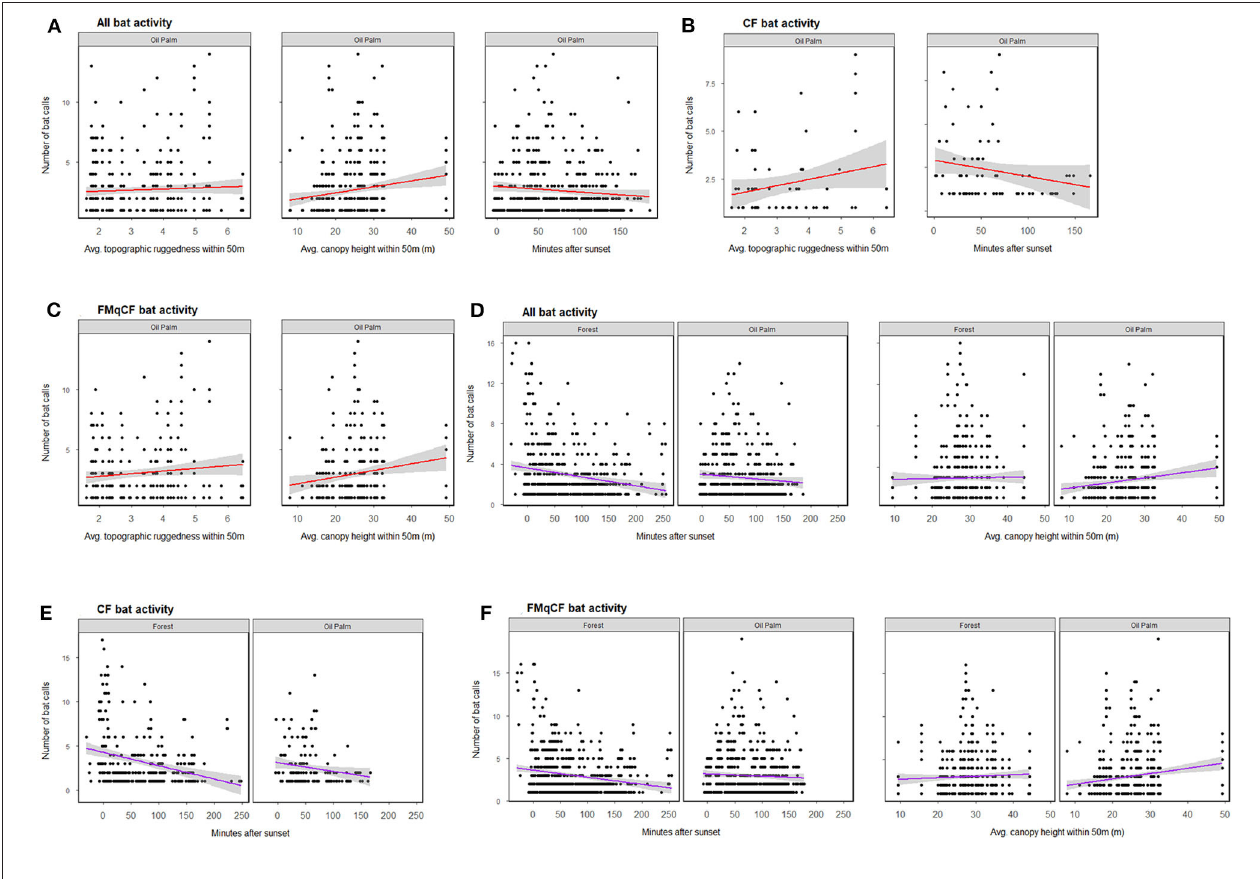
FIGURE 3 | The relationship between bat activity (per sample point) and significant habitat covariates as determined by GLMM analysis for each call group per habitat type. (A–C) Show relationships from GLMMs assessing oil palm exclusively; (D–F) show relationships within both forest and oil palm. Shading represents 95% confidence